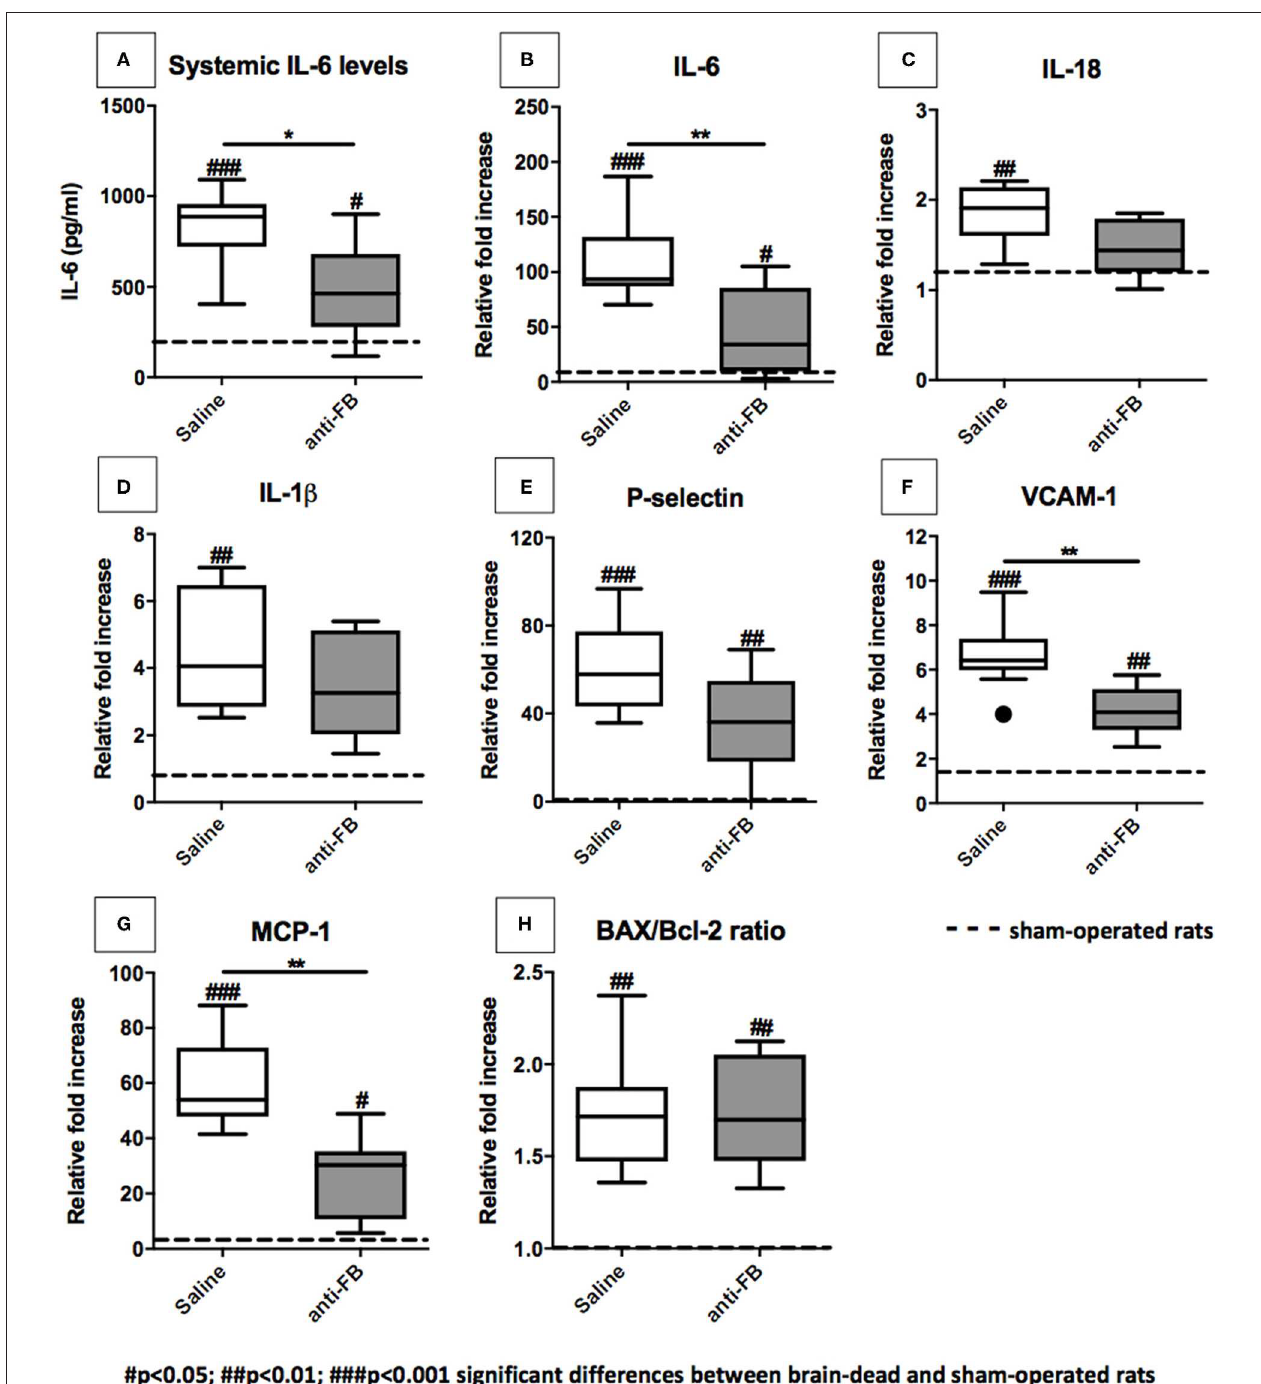
FIGURE 4 | Pro-inflammatory gene expression levels in the kidney after 4h of brain death. (A) Systemic IL-6 levels of brain-dead rats treated with saline or anti-FB compared to sham-operated rats after 4h of brain death. A rat enzyme-linked immunosorbent assay determined plasma levels of IL-6. All samples were analyzed in duplicate and measured at an OD of 450nm. Pro-inflammatory gene expressions in the kidneys of brain-dead rats treated with saline or anti-factor B. mRNA expressions of (B) IL-6, (C) IL-18, (D) IL-1 β , (E) P-selectin, (F) VCAM-1, (G) MCP-1, and (H) BAX/Bcl-2 ratio. Data are shown as expression relative to β -actin as set at 1 in sham-operated rats, the other values, are calculated accordingly. Data are shown as median ± IQR. Data were analyzed by Mann Whitney- U -test and Bonferroni post-hoc test, asterisks above the bars denote significant differences between the brain-dead rats (* p < 0.05, ** p < 0.01, and *** p < 0.001). The dashed line represents the sham-operated rats. # Significant differences between the brain-dead rats vs. sham-operated rats ( # p < 0.05, ## p < 0.01, and ### p < 0.001). Anti-FB, anti-factor B.